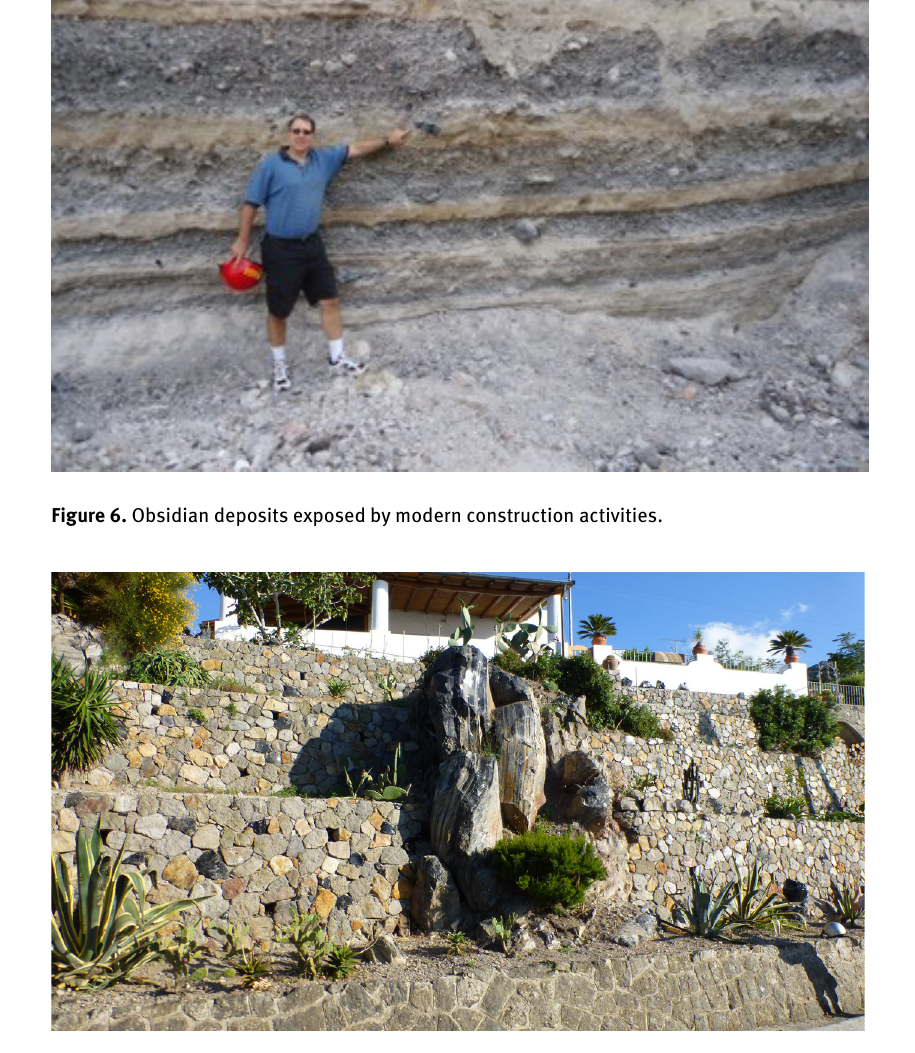
Figure 7. Obsidian block near Roche